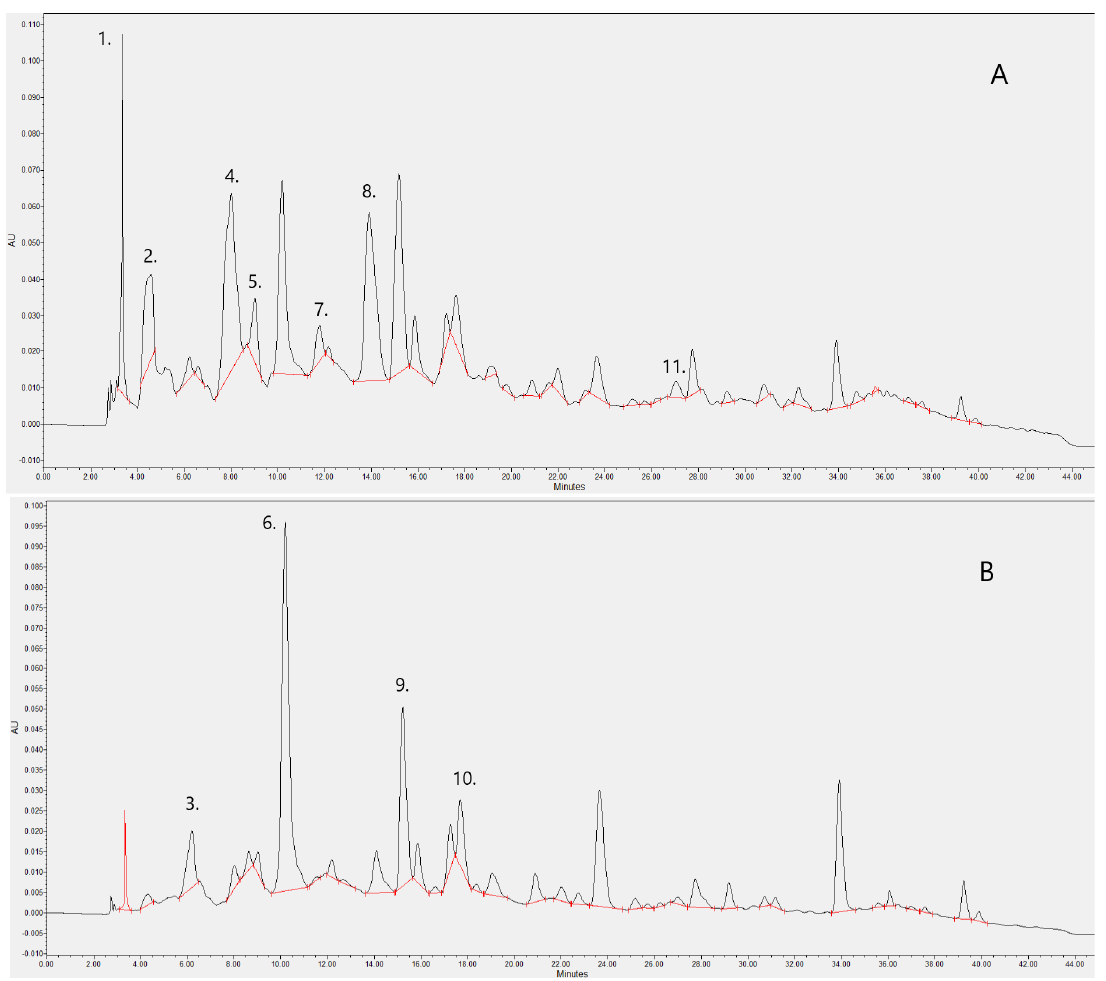
Figure 1. Polyphenols of HAE were analysed on a Hypersil ODS 250 mm × 4.6 mm column with 5µm particle size using gradient elution and the compounds were detected at 280 nm ( A ) and 320 nm ( B ). The following peaks were identi fi ed on the basis of the retention time of the authentic stand-